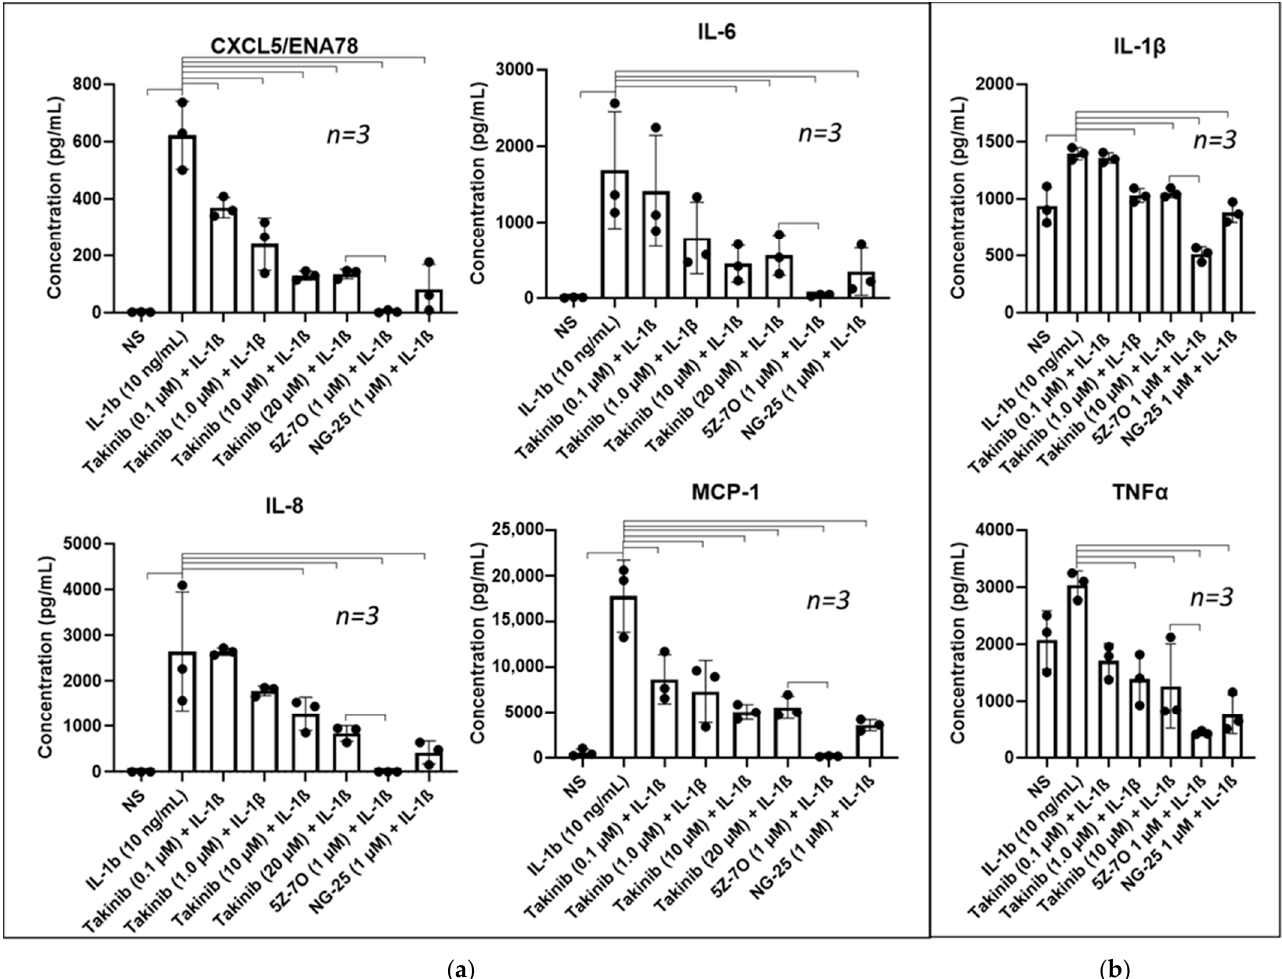
Figure 1. Inhibition of TAK1 reduces proinflammatory mediators. ( a ) RASFs were pre-treated with selected inhibitors followed by 24 h stimulation with IL-1 β (10 ng/mL). Supernatants were collected and analyzed by ELISA. Takinib demonstrates inhibition of CXCL5, IL-6, IL-8, and MCP-1 though not as completely as 5Z7O or NG-25. ( b ) THP-1 monocyte- derived macrophages pre-treated with selected inhibitors followed by 24 h stimulation with LPS (10 µg/mL). Supernatants collected and analyzed by ELISA demonstrate significant reduction in both IL-1 β and TNF α . 5Z7O lowered both cytokines significantly more than any treatment of takinib. Significance bars represent p < 0.05 in one-way ANOVA with Dunnett’s post hoc test for multiple comparisons to either IL-1 β or LPS.